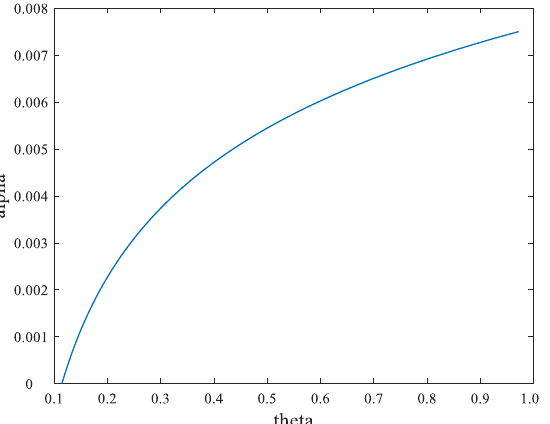
Figure 1. The absolute risk aversion coefficient of the policyholder and the risk premium.